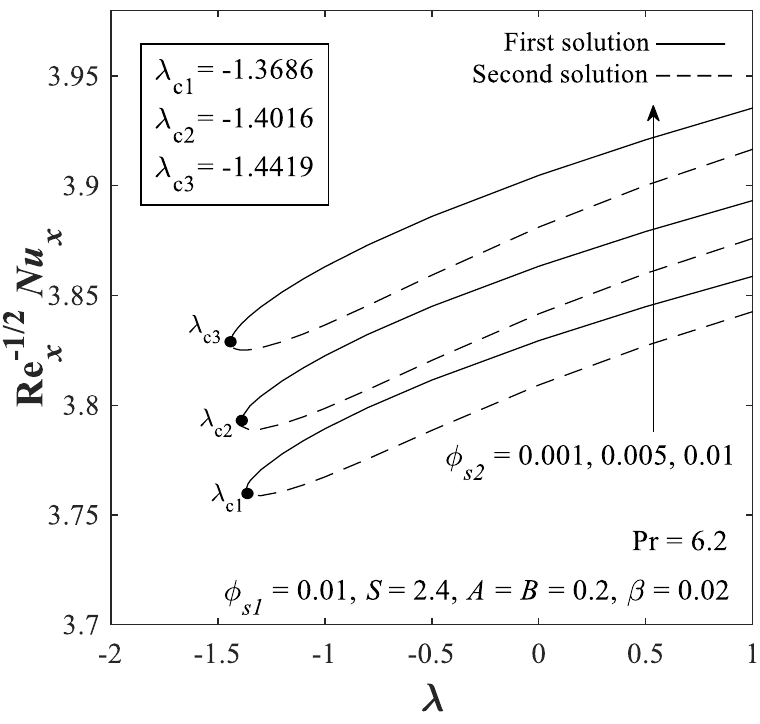
Figure 7. Plot of Re − 1/2 x Nu x with λ for varied φ s 2 .